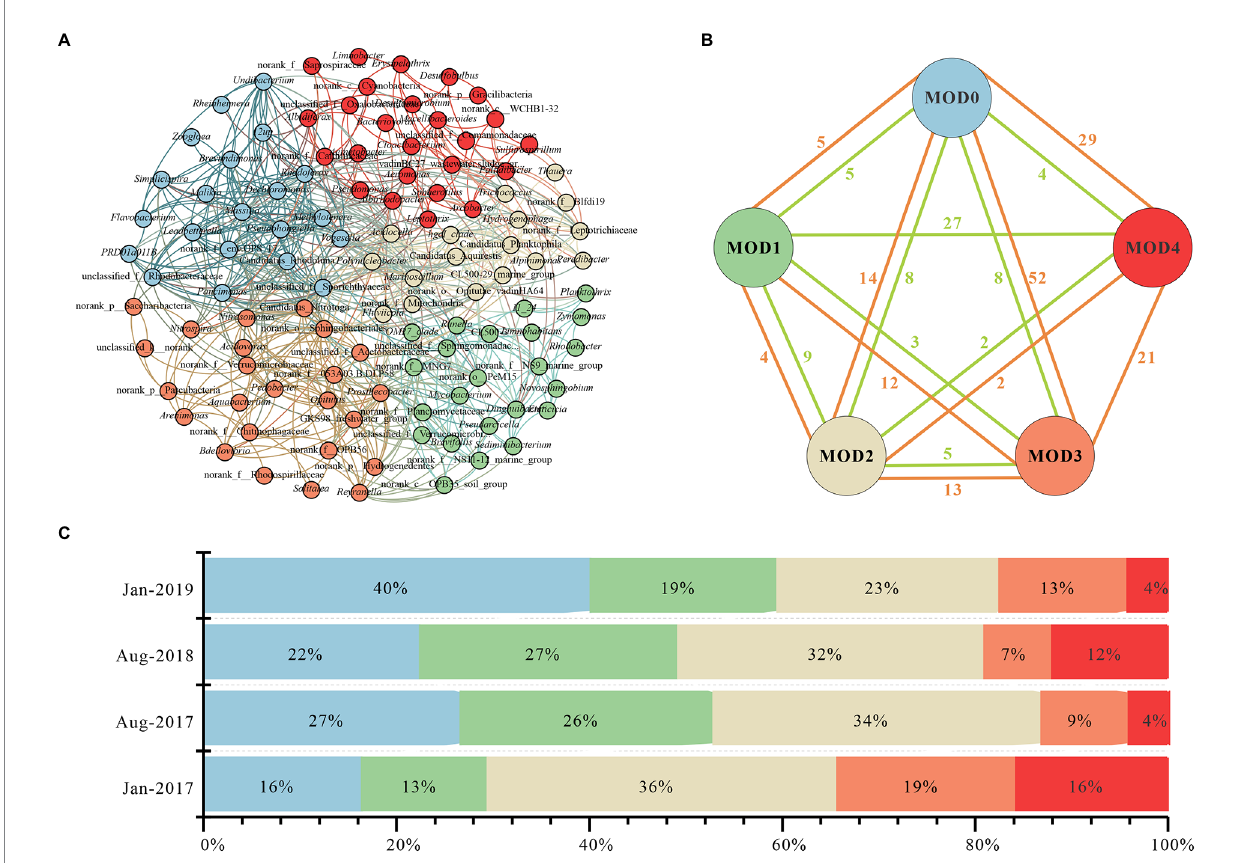
FIGURE 4 Interactions of microbial community in karst river. (A) Co-occurrence network of genus with relative abundance above 0.1%. Genus with relative abundance above 0.1% were selected to calculate their correlations. Each node represented a genus, the nodes were colored by module, and the connection between nodes represented a significant correlation (Spearman, p < 0.05, | r | > 0.6). (B) Connections of modules. The correlation of each genus in every module, negative relations were represented in green edges and positive relations were represented in orange edges. (C)